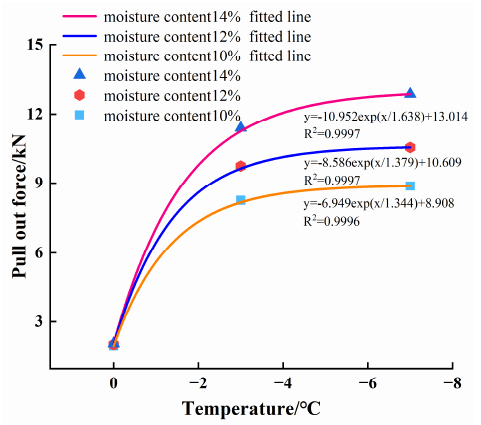
Figure 16. Extremes of pull-out force versus freezing temperature curve.